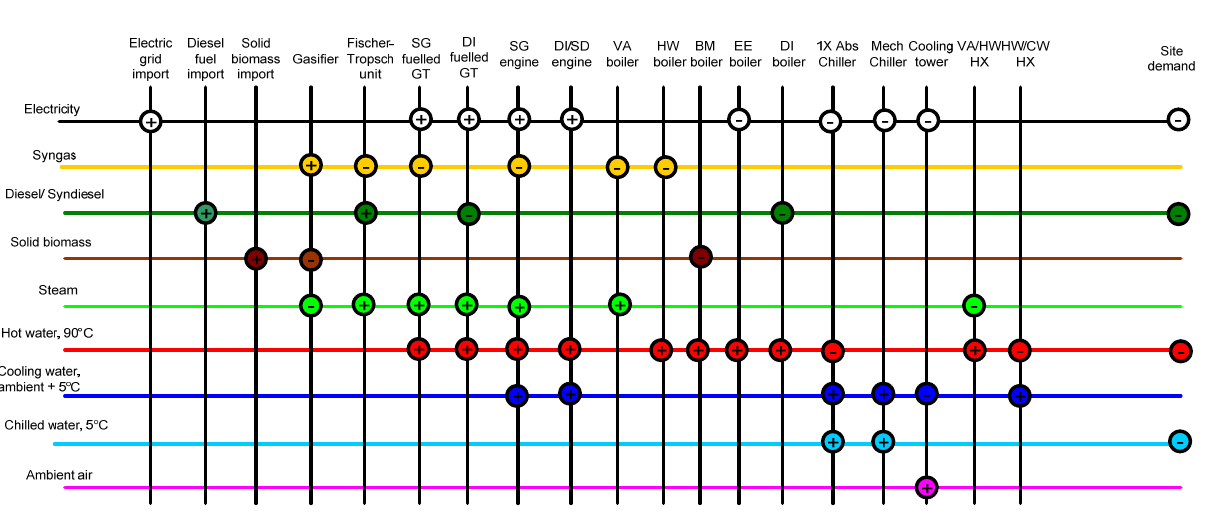
Figure 7. Initial superstructure for example application illustrating all potential conversion pathways